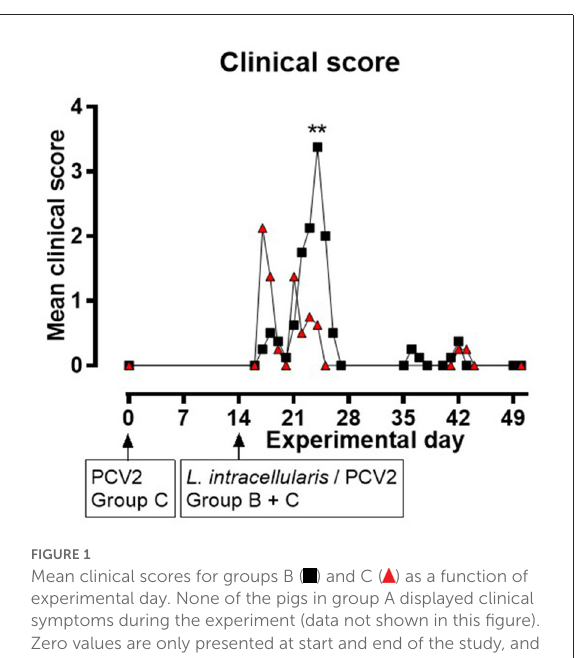
FIGURE1 Mean clinical scores for groups B ( ) and C ( ) as a function of experimental day. None of the pigs in group A displayed clinical symptoms during the experiment (data not shown in this figure). Zero values are only presented at start and end of the study, and when next to a positive data point. Significant results ( p < 0.01) are marked by **.